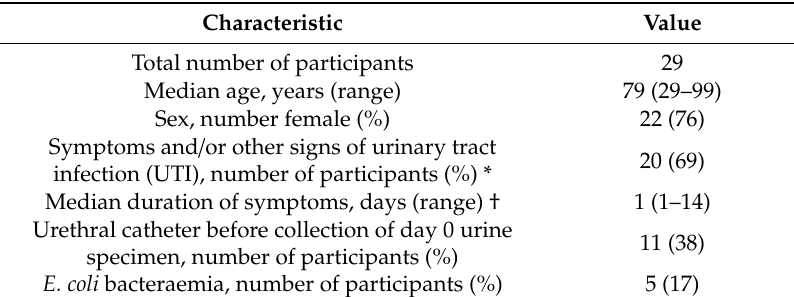
Table 1. Characteristics of